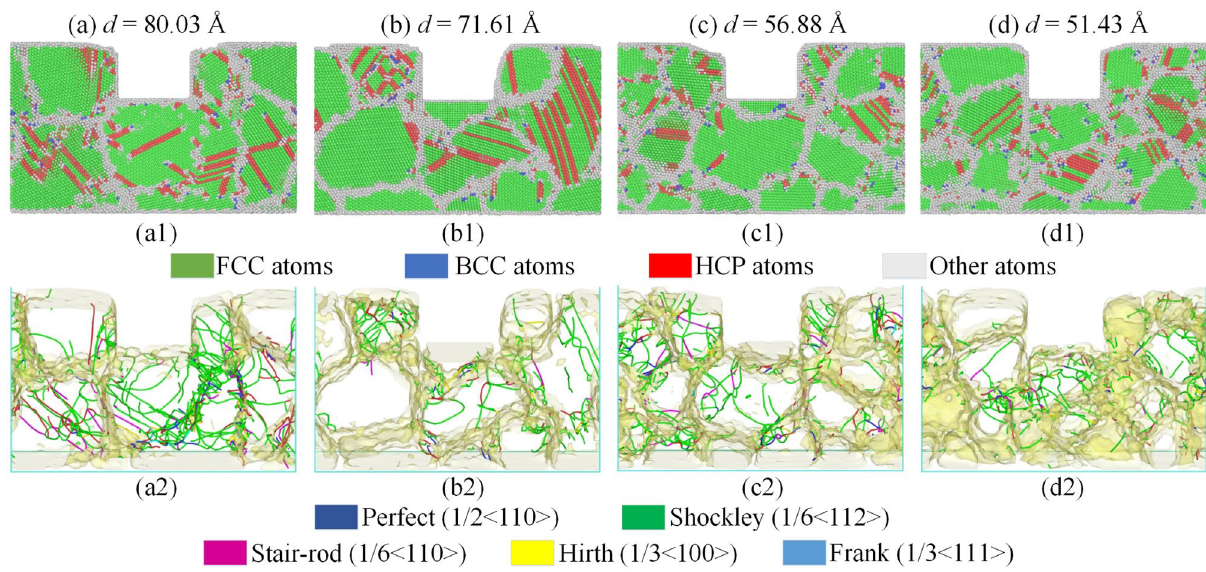
Figure 12. The microstructure snapshots ( a1 – d1 ) and distribution of the identified dislocations ( a2 – d2 ) at an imprinting depth of 30 Å for polycrystalline samples of the Al0.5 HEA with various grain sizes: 80.03 Å ( a ); 71.61 Å ( b ); 56.88 Å ( c ); and 51.43 Å ( d